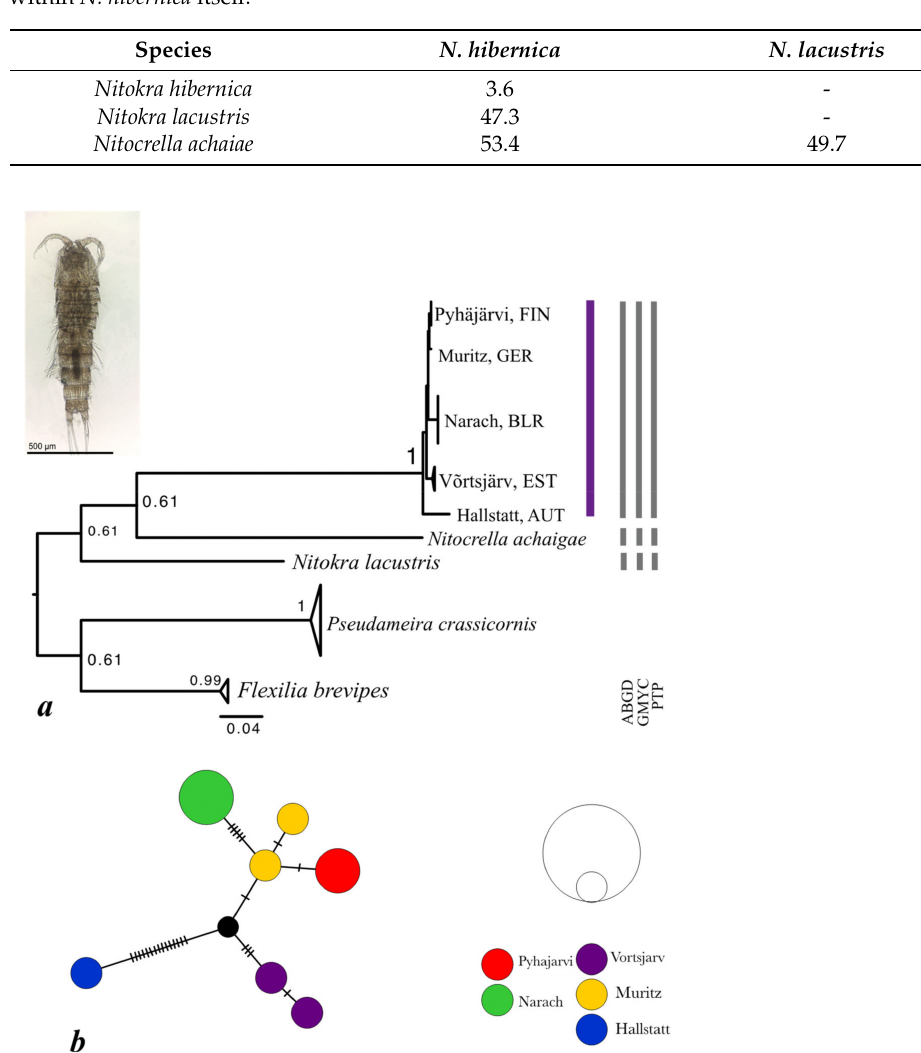
Table 6. Average model-corrected COI distances (%) between Nitokra and Nitocrella species, and within N. hibernica itself.